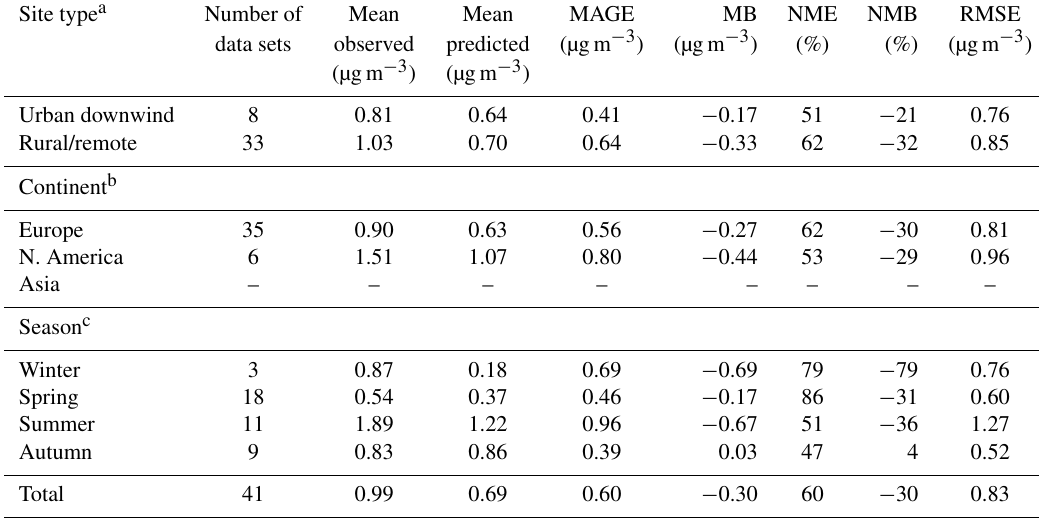
Table 6. Statistical evaluation of EMAC fresh SOA against AMS SV-OOA in the Northern Hemisphere during 2001–2010. Site type a Number of Mean Mean MAGE data sets observed predicted (µgm − 3 ) Urban